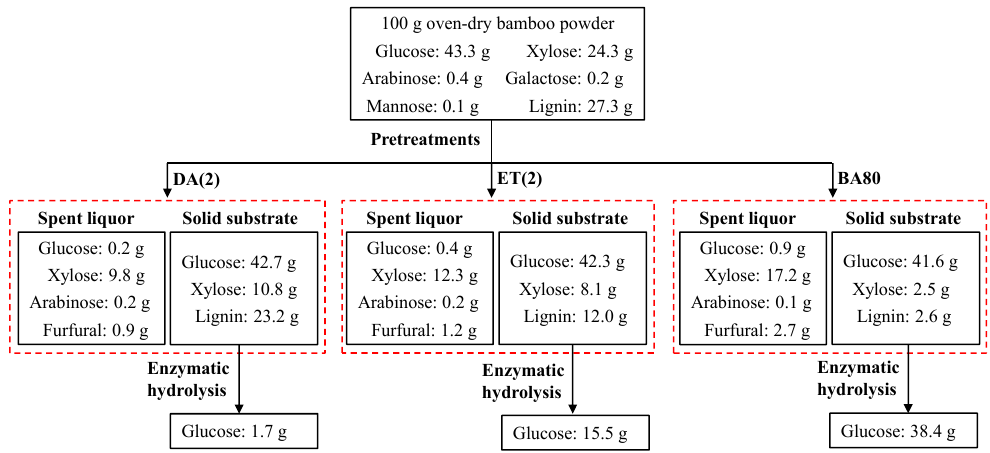
Figure 7. Mass balance of glucose during DA(2), ET(2), and BA80 pretreatments and enzymatic hydrolysis. Three pretreatments (DA(2), ET(2), and BA80) were conducted under optimized conditions that are detailed in Figure 4. Cellulase and soy protein loadings of the enzymatic hydrolysis were 4 FPU/g glucan and 100 mg protein/g substrate.